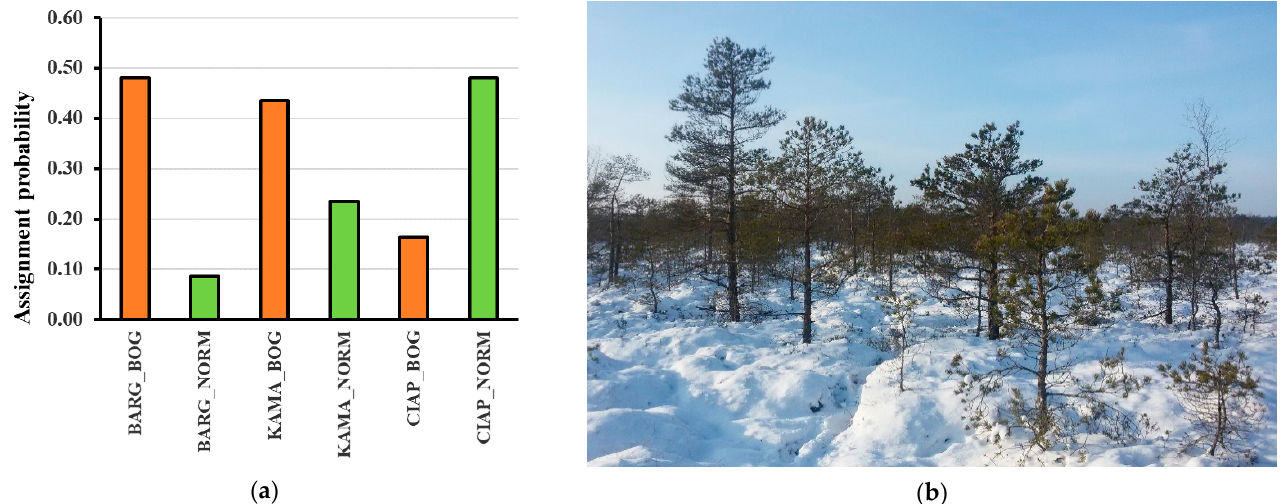
Figure 5. ( a ) The mean GENECLASS assignment probabilities of the four ancient Scots pine individuals (P_2, B_1, C_2 and T_3) to the pairs of the adjacent wetland (BOG) and dryland (NORM) populations of Scots pine at three locations in Lithuania (KAMA, north; BARG, center; and CIAP, south of the country, Figure 1). ( b ) The reference population Scots pine in the wetland of Bargailiai (during sampling in the raised bog, age of Scots pine trees circa 100 years, estimated by sampling the increment cores). The adjacent dryland reference population of BARG is seen at the horizon.